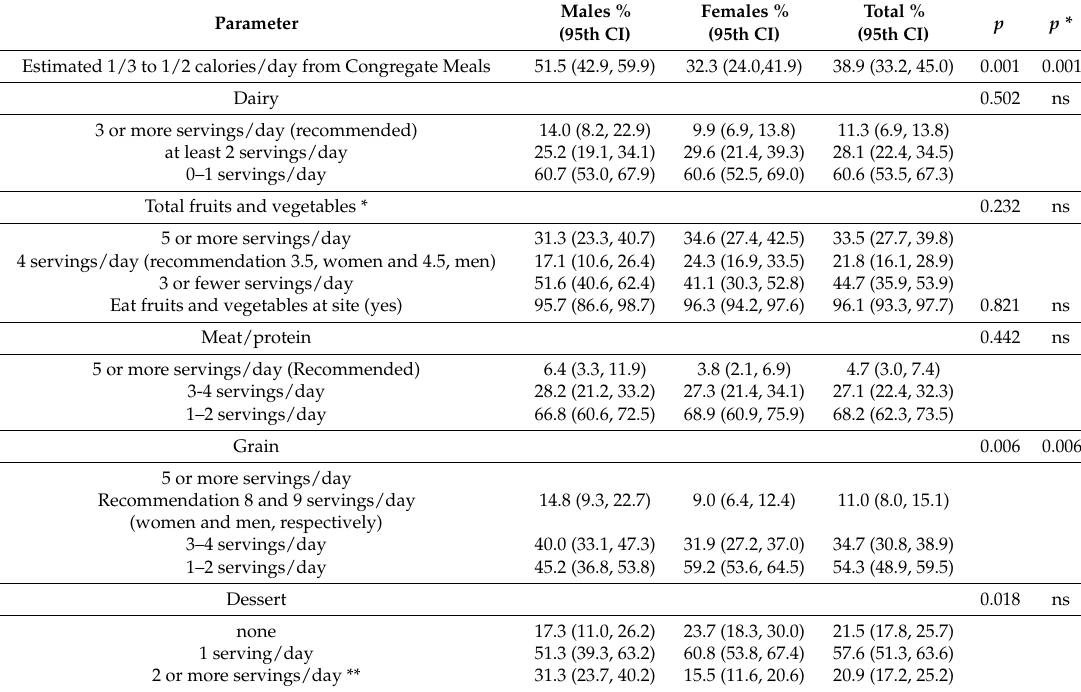
Table 3. Chi-squared test for the estimated proportion of calories consumed at the site and total servings per day (home and site, combined) of major food groups and dessert by